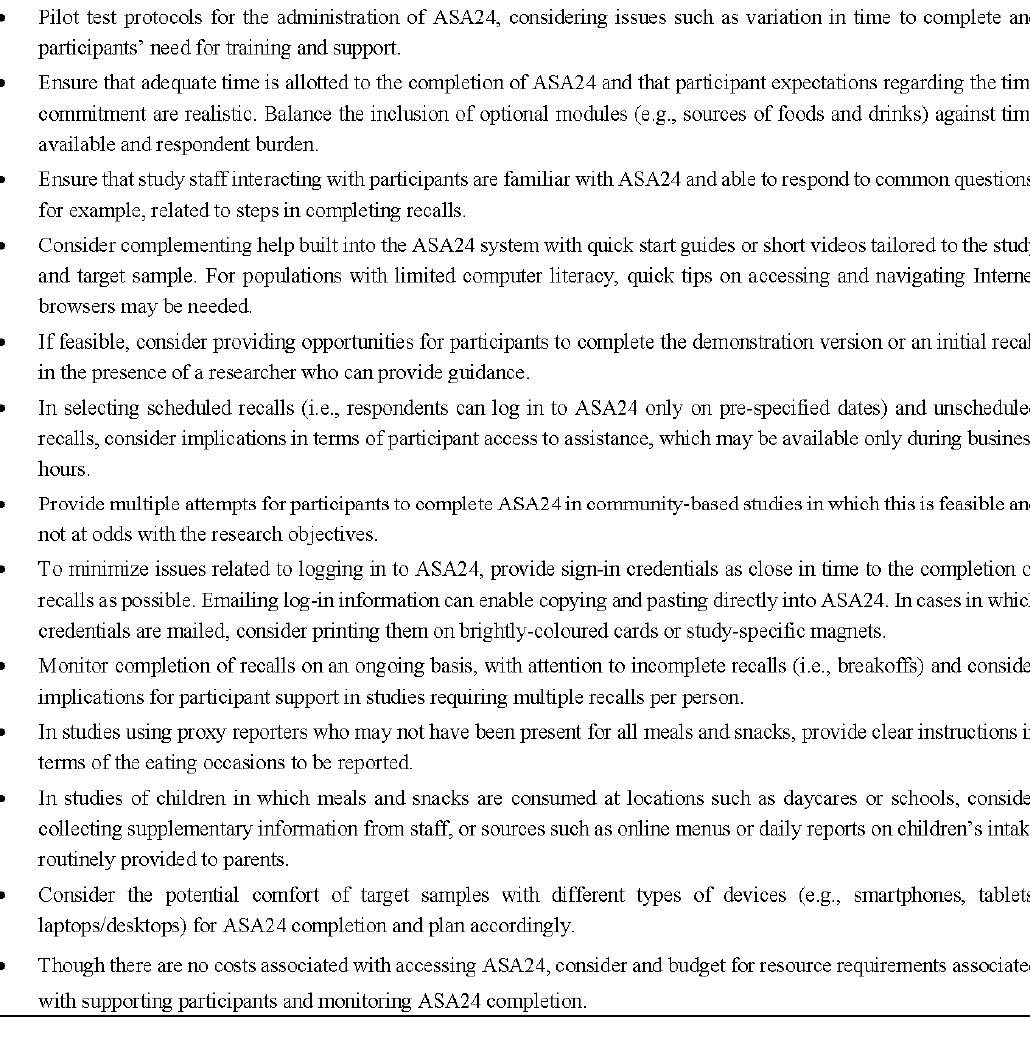
Figure 4. Considerations in implementing ASA24 in research studies.